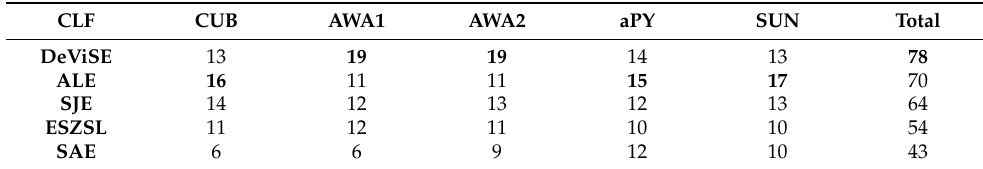
Table 8. Individual Classifier Combined Performance.